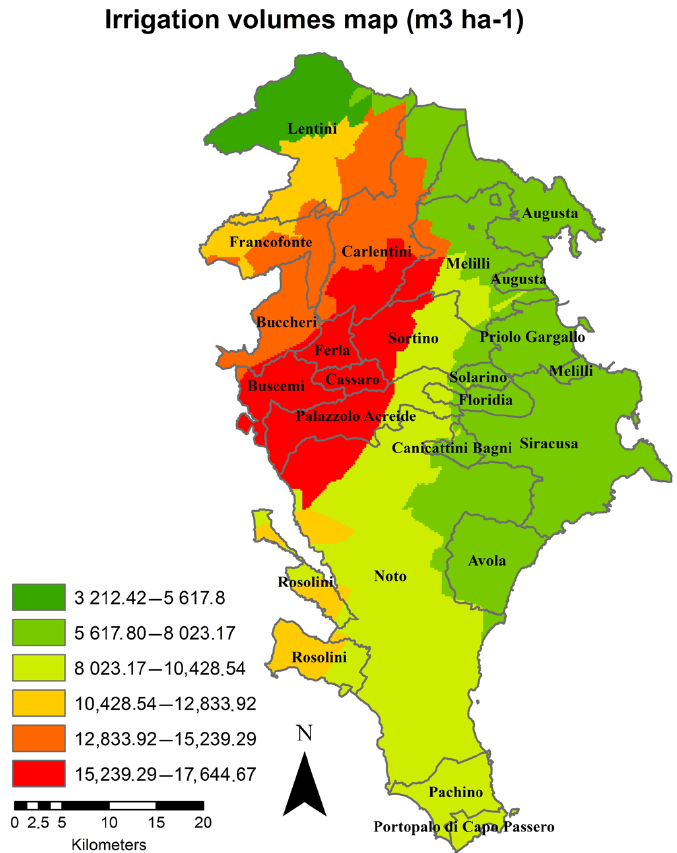
Figure 2. Irrigation volumes map with data from the A.C.Q.U.A. project.